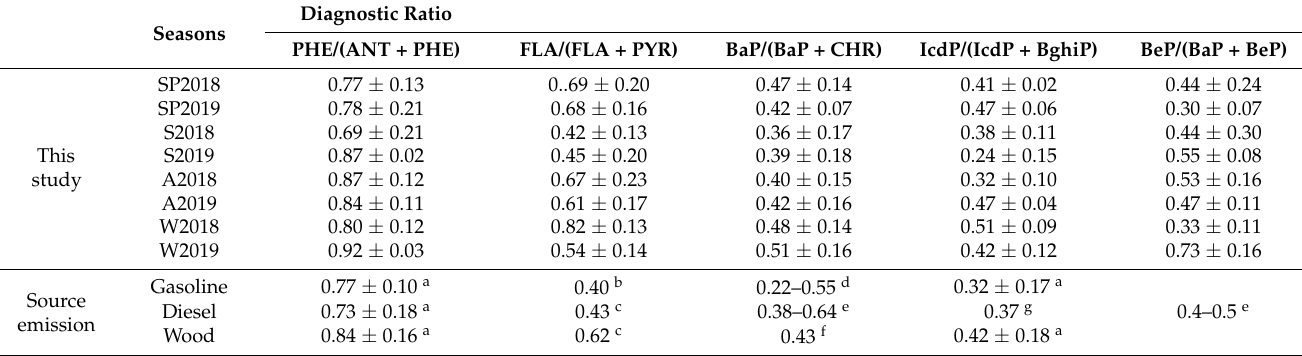
Table 2. Comparison among PAH ratios obtained from samples from this study for four seasons and possible emission sources in the Strasbourg